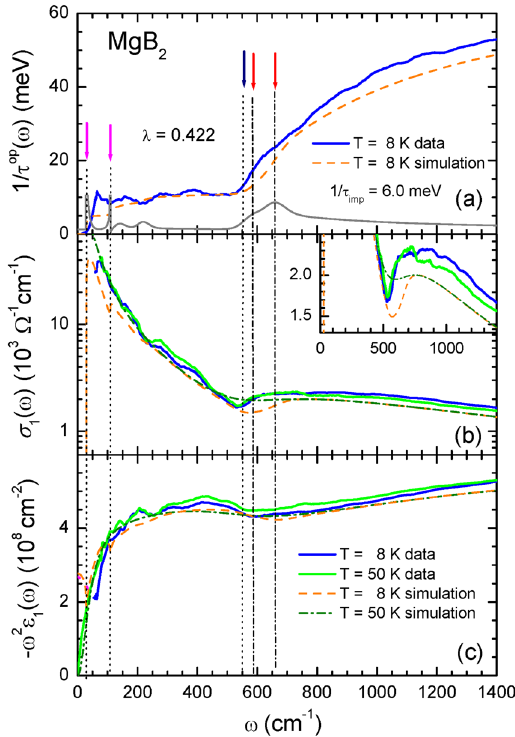
Figure 4. ( a ) The measured optical scattering rate, 1/ τ op ( ω ) at 8 K (superconducting state), and the optical scattering rate calculated using Allen’s formula 17 together with α 2 F ( ω ) extracted from the 1/ τ op ( ω ) data at 50 K through a maximum entropy (ME) fitting. The grey line is the derivative of the simulated optical scattering rate at 8 K. ( b ) The optical conductivity data at 8 K and 50 K and simulated values obtained using the extracted α 2 F ( ω ) through a reverse process 32 . In the inset, we display a magnified view in order to show the dips of the measured and simulated data near 550 cm − 1 . ( c ) The quantity  ω ω − ( ) 2 at 8 K and 50 K, and corresponding 1 simulated values. The two magenta arrows mark the positions of the superconducting gaps: 2 Δ π and 2 Δ σ . The dark blue arrow marks the position, Ω R , of the strong (or major) peak of α 2 F ( ω ). The two red arrows mark the positions of the characteristic energy scales, Ω R + 2 Δ π and Ω R + 2 Δ σ